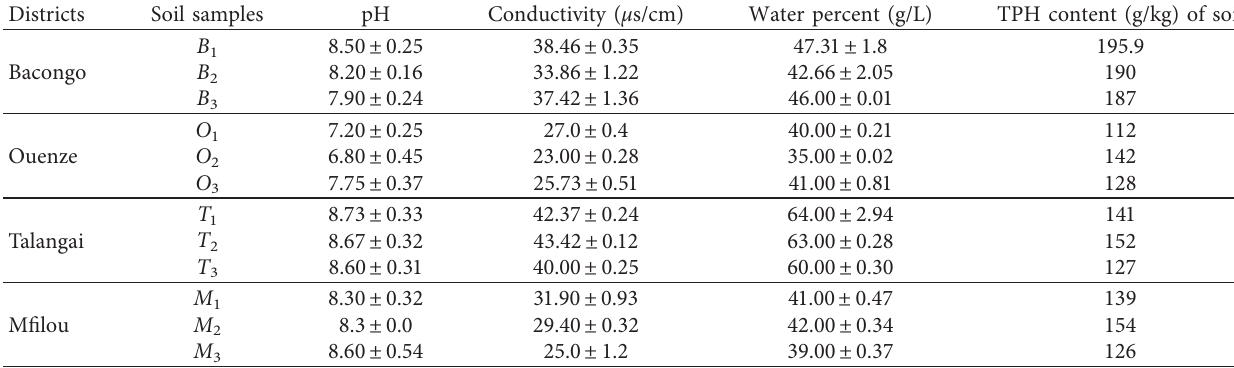
Table 1: Results of pH, conductivity, water percent and TPH